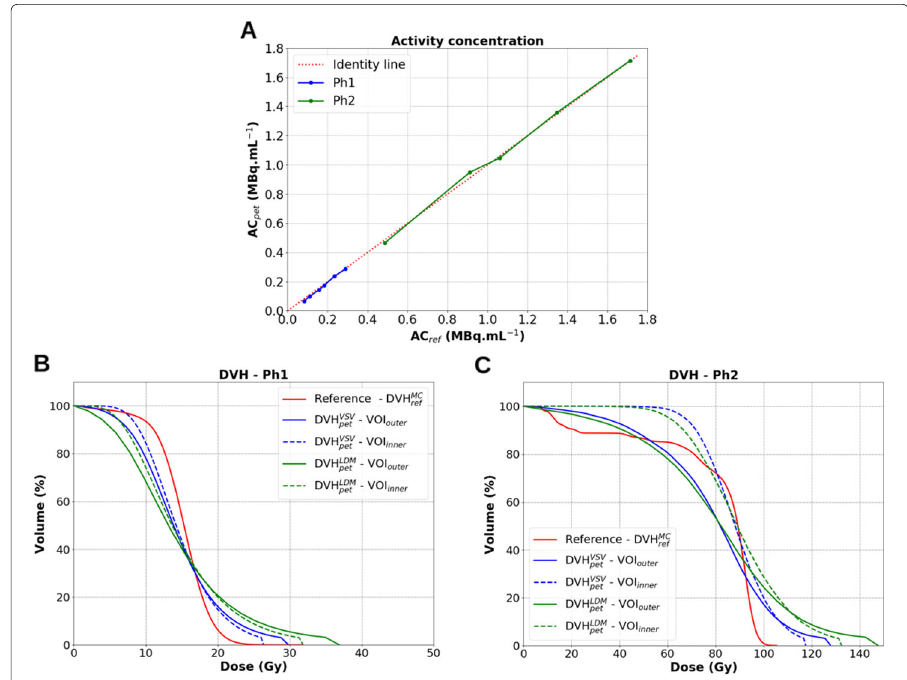
Fig. 2 Quantitative accuracy of 90 Y acquisitions for image reconstructions with Recon1 . A AC pet against AC ref for both Ph1 and Ph2. B , C Comparisons of DVH VSV pet (blue lines) and DVH LDM pet (green lines) to DVH MC for Ph1 at AC ref = 0.29 MBq mL − 1 and Ph2 at AC ref = 1.71 MBq mL − 1 ,